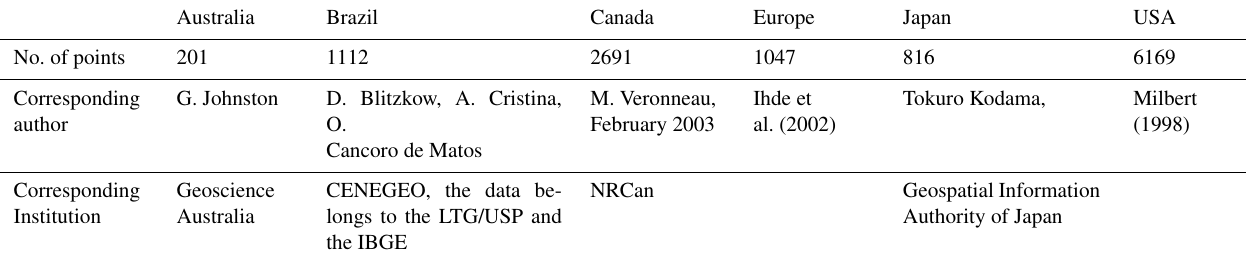
Table 3. Information on the GNSS/levelling benchmark points ICGEM collected during the years and corresponding authors/institutions.